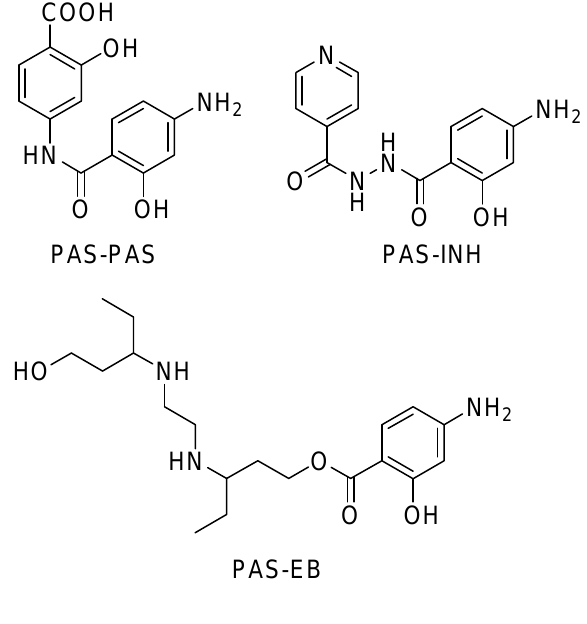
Figure 35. Chemical structures of the mutual prodrugs (PAS = para -aminosalicylic acid; INH = isoniazid; EB =